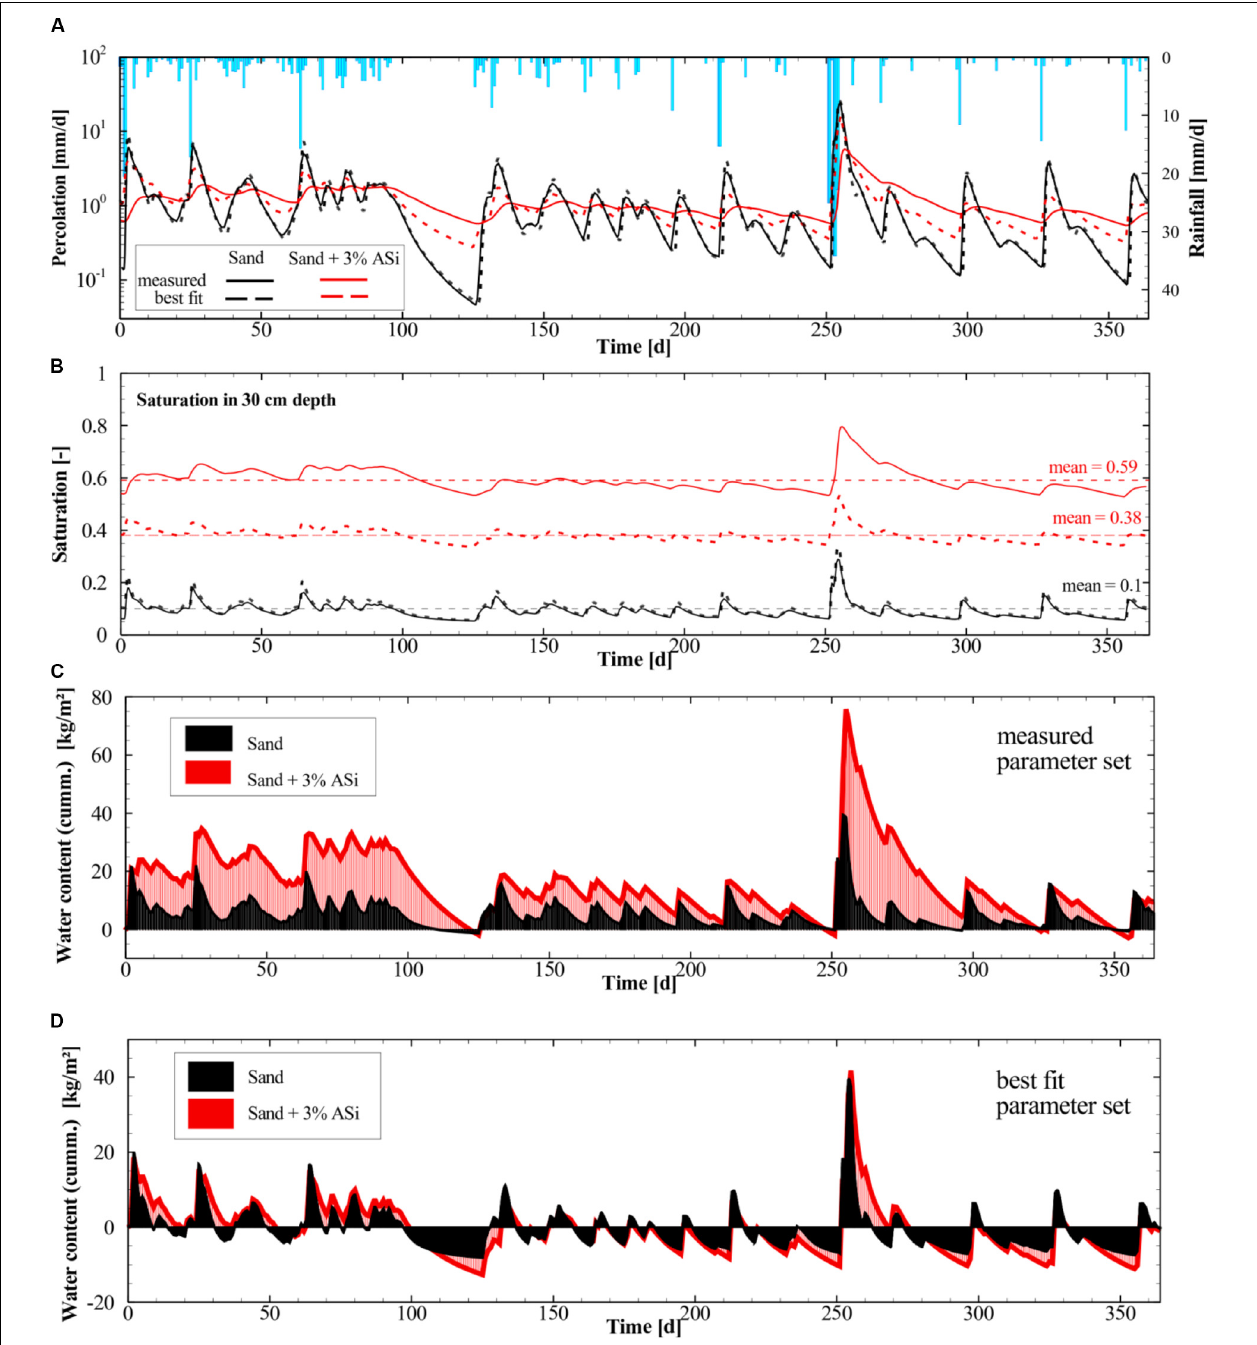
FIGURE 10 | (A) Applied rainfall rates for the yearly simulation scenario (November 1st 2017 to October 31th 2018) and the modeled percolation rates for the pure sand and the sand with 3% ASi. (B) Simulated water saturation at 30 cm depth for the measured and best fit parameter set. (C) Simulated cumulative water uptake in kg per unit area for the sand and sand with 3% ASi for the measured parameter set listed in Table 1 (water uptake is relative to the initial water content; D ) Simulated cumulative water uptake in kg per unit area for the sand and sand with 3% ASi for the best fit parameter set (water uptake is relative to the initial water